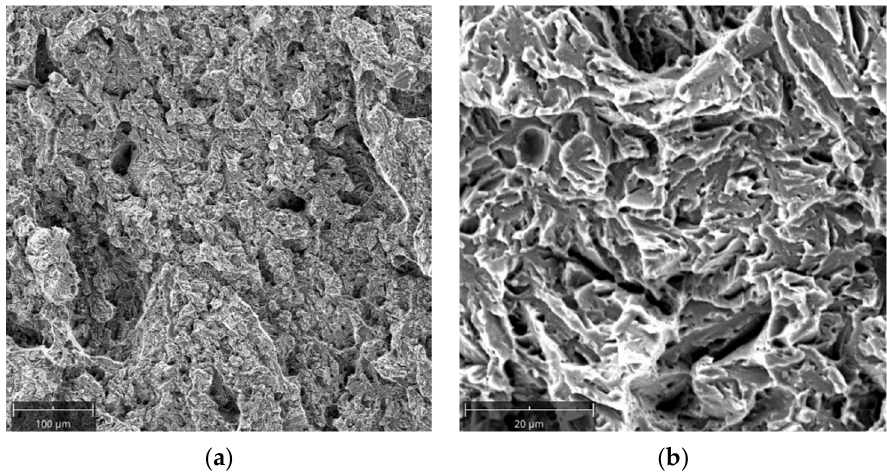
Figure 9. Fracture surfaces of the investigated die insert: ( a ) low magnification, ( b ) high magnification.